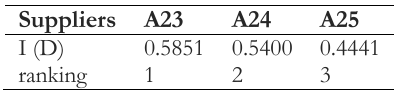
Table 6. Ranking of suppliers of parts category D.